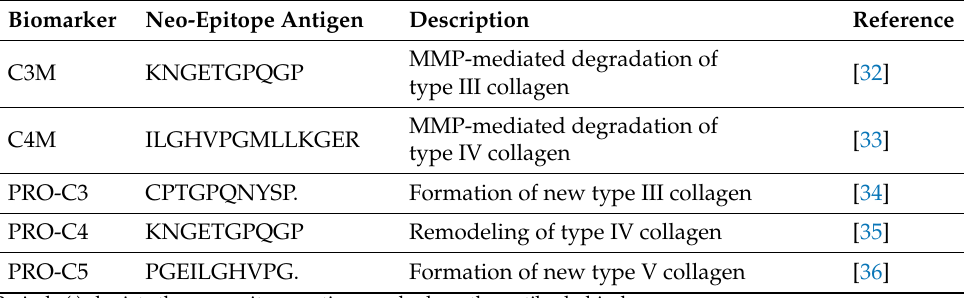
Table 1. Overview of the ECM neo-epitope